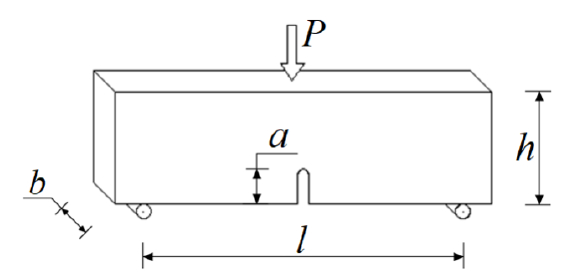
Figure 6: Scheme of the three point bending test with the notch.